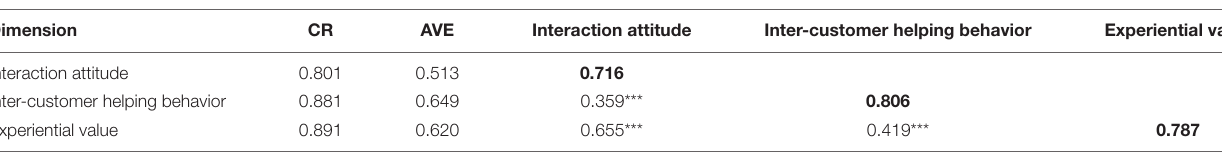
TABLE 6 | Validity matrix (complete